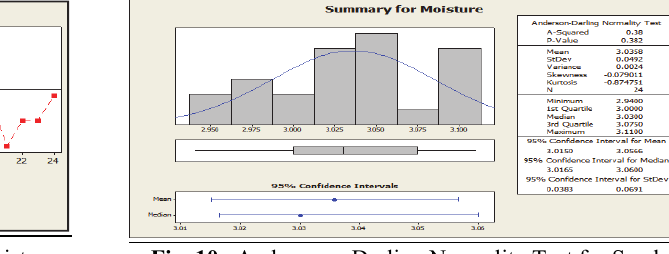
Fig. 9. Data Independence Test of Moisture Fig. 10. Anderson – Darling Normality Test for Sand